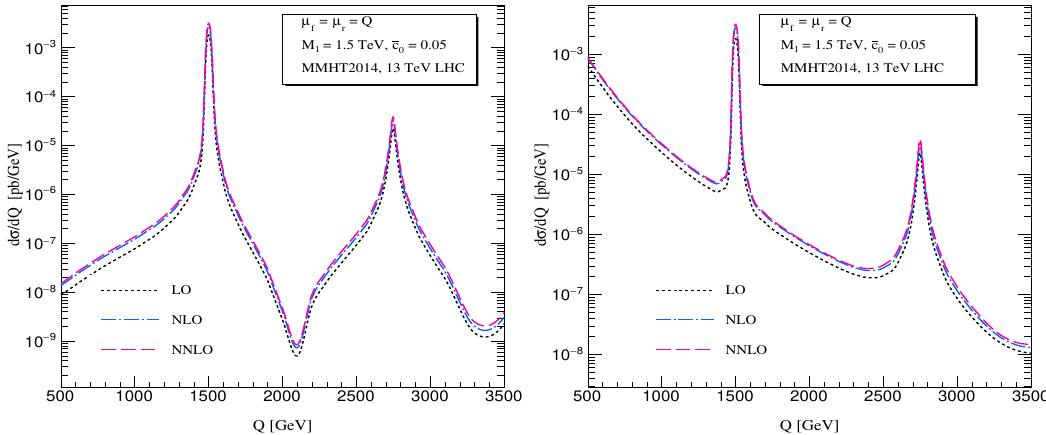
Figure 2 . Di-lepton invariant mass distribution up to NNLO QCD for pure RS model (left panel) and for the signal (right